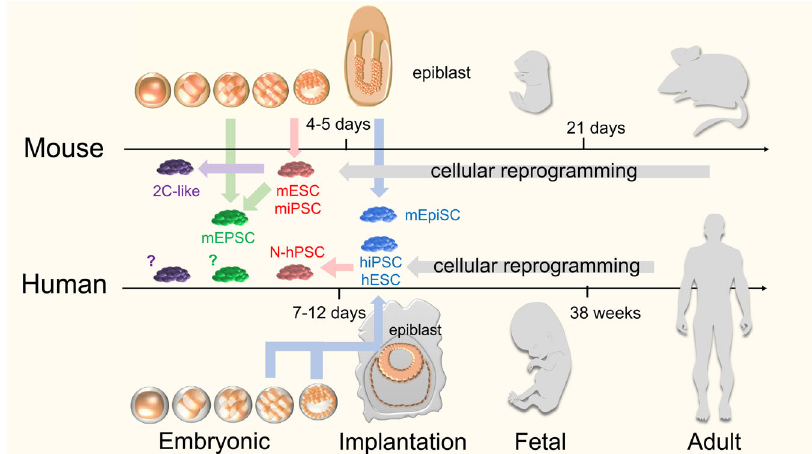
Fig. 1 Comparative incongruence of murine and human embryonic and developmental stages. Top: Murine ESC (mESC; red) are derived from pre-implantation morula- or blastocyst-staged murine embryos, and capture a naïve epiblast-like pluripotent state. mESCs can differentiate into all three germ-layers via in vitro directed differentiation, in vivo teratomas, and in vivo morula/blastocyst chimera assays. The murine pluripotent state can also be obtained through epigenetic reprogramming of somatic cells with ectopic expression of Yamanaka factors. Murine extended potential stem cells (mEPSCs; green) possess both embryonic and extra-embryonic differentiation potency and can be derived via chemical reprogramming of cleavage-stage murine blastomere cells of mESCs. Stem cells resembling the molecular phenotype of 2-cell (2C) cleavage-staged blastomeres (purple) putatively possessing totipotent-like molecular characteristics can be isolated from mESC cell cultures 122 , or through the inductive expression of key totipotent factors (e.g., Dux and NELF-A ). Bottom : Although conventional hESC (blue) are similarly derived from the pre-implantation stages of IVF-derived morula or blastocyst-staged human embryos, they are phenotypically similar in culture with post-implantation primed murine epiblast stem cells (mEpiSC; blue). A primed, mEpiSC-like state of pluripotency is also attained through the epigenetic reprogramming of human somatic cells by Yamanaka factors into hiPSC. Multiple methods for reverting conventional hPSC to naïve human pluripotent stem cells (N-hPSC; red) with mESC-like pluripotency have been reported employing various small molecule inhibitor cocktails or via transgene expression of key factors 10 . Self-renewing human totipotent stem cells (purple) with phenotypic equivalence to four to eight-cell or cleavage stage human blastomeres have not yet been